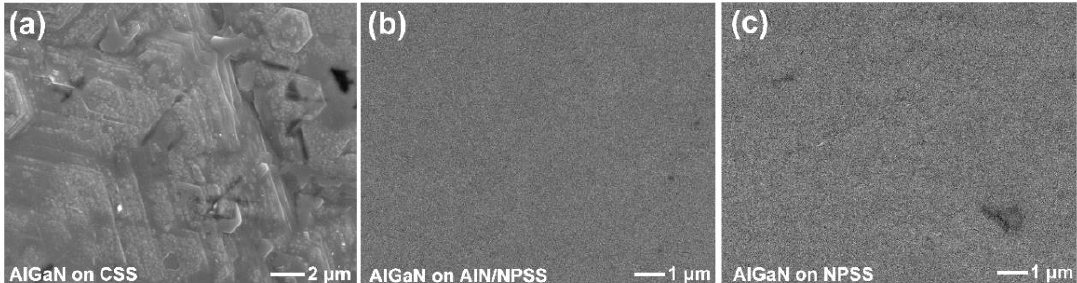
Figure 3. Top-view SEM images of the surface morphologies of the ( a ) CSS; ( b ) AlN/NPSS; and ( c ) NPSS [17].